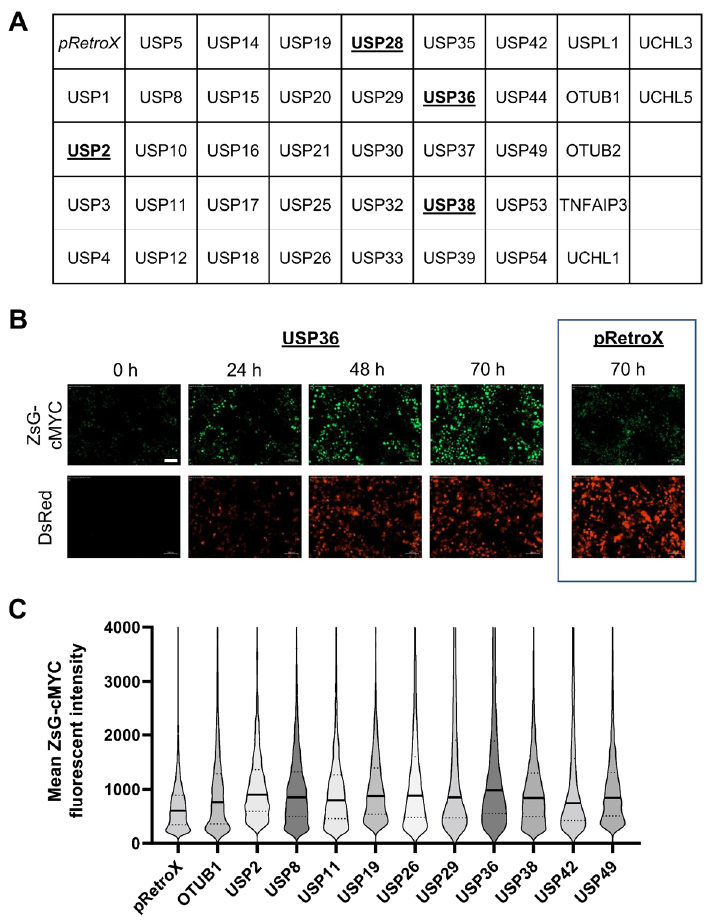
Figure 3. Screen for altered ZsGreen1-c-MYC protein levels following overexpression of deubiqui- tinases. ( A ) The stable HeLa reporter cell line expressing ZsGreen1-c-MYC was transfected with an empty vector (pRetroX-IRES-DsRedExpress) or with 1 of 41 deubiquitinases, cloned into pRetroX- IRES-DsRedExpress. Deubiquitinases with previously published activity on c-MYC are underscored. Cells were transfected with the deubiquitinase-encoding vectors at the beginning of the ex- periment, and images were taken every 2 h. Additional information on the screen is provided in Figures S2 and S3. ( B ) Microscopy time course of the known c-MYC-specific deubiquitinase USP36 with expression of the ZsGreen1-c-MYC fusion protein (top panel) and the USP36- and dsRedEx- press-encoding vector (bottom panel). Cells transfected with the empty control vector pRetroX- IRES-DsRedExpress are shown on the right (70 h time point depicted). The scale bar represents 100 μ m. ( C ) Quantification of ZsGreen1-c-MYC fluorescence at time point 72 h (median in bold). Multi- ple visual fields and a minimum of 2400 cells were analyzed per transfected cell batch. Eleven deubiquitinating enzymes increased ZsGreen1-c-MYC levels, including eight new and three previ- ously published candidates (USP2, USP36, and USP38). Fluorophore bleed-through was excluded prior to analysis. The minimum difference in ZsGreen1-c-MYC expression corresponds to p < 2.3 × 10 -33 (Wilcoxon rank-sum test with Bonferroni correction) at the 72 h time point and showed a tra- jectory of increase compared to the empty vector control over time.